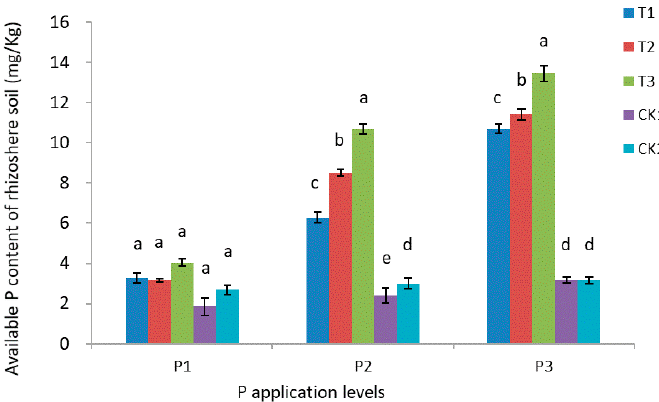
Figure 2. Effects of PSB on available phosphorus content of C. oleifera . Note: Data are means ± SD ( n = 3). Different lowercase letters within the same column indicate significant differences ( p ≤ 0.05).